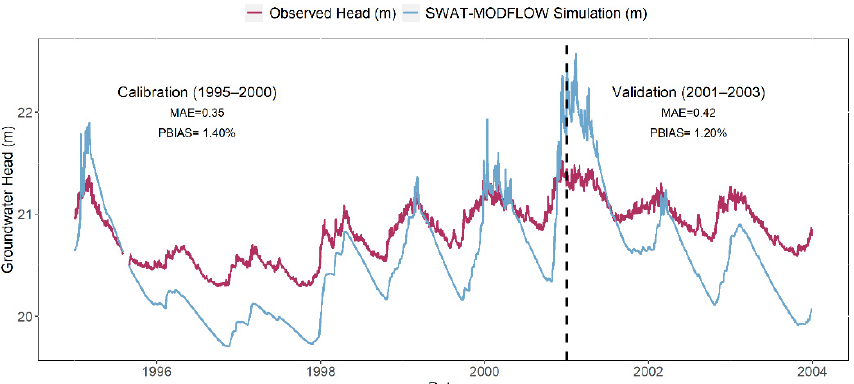
Figure 16. Comparison of simulated groundwater level from coupled SWAT-MODFLOW at Moni- toring Well 1 for the period of 1995–2000. Table 7. Statistics of simulated groundwater level of the coupled SWAT-MODFLOW model for the calibration and validation periods.